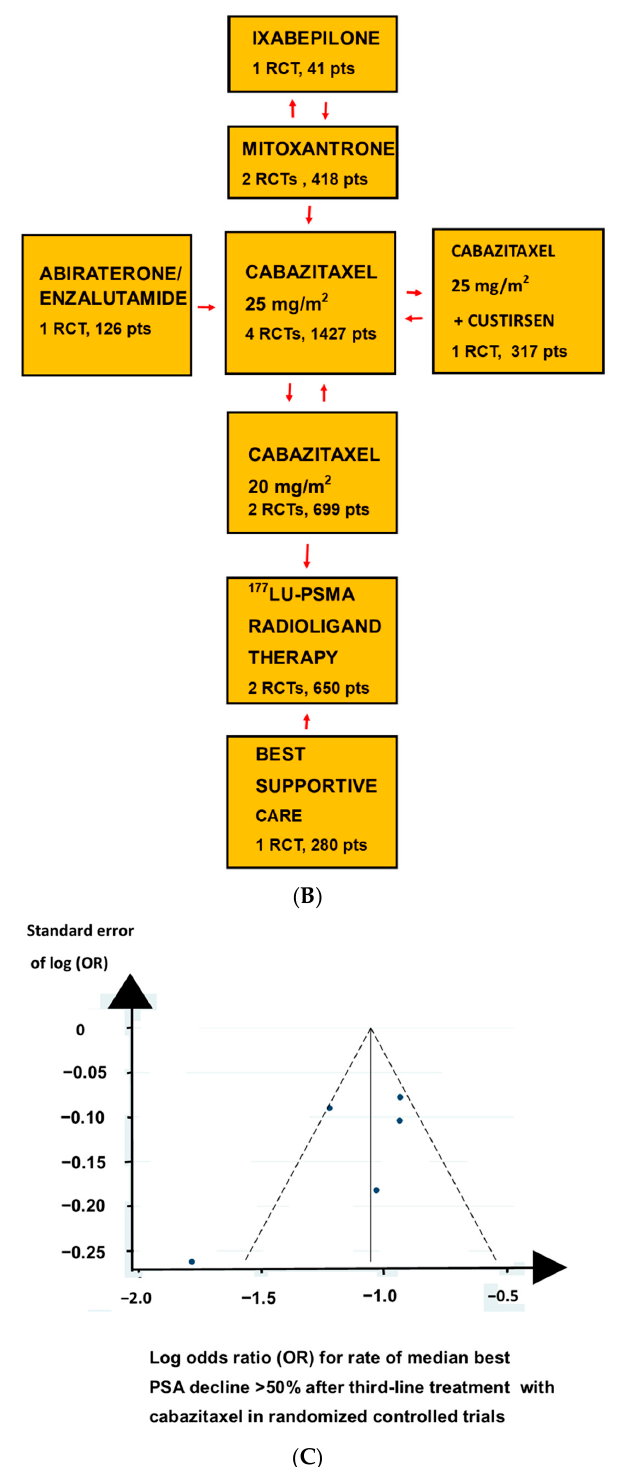
Figure 1. ( A ). In this systematic review of the network meta-analysis, we searched for RCTs in three databases. The selection process is shown as a PRISMA flow diagram. ( B ). The L3 treatments connected the RCTs in a network with a ladder and a star configuration without any loops. A single arrow between two treatments points to the most effective treatment, and double arrows indicate non-inferiority between the treatments. ( C ). L3 treatment with cabazitaxel resulted in rates of median PSA decline ≥ 50% that had a symmetric distribution with only one outlier in a funnel